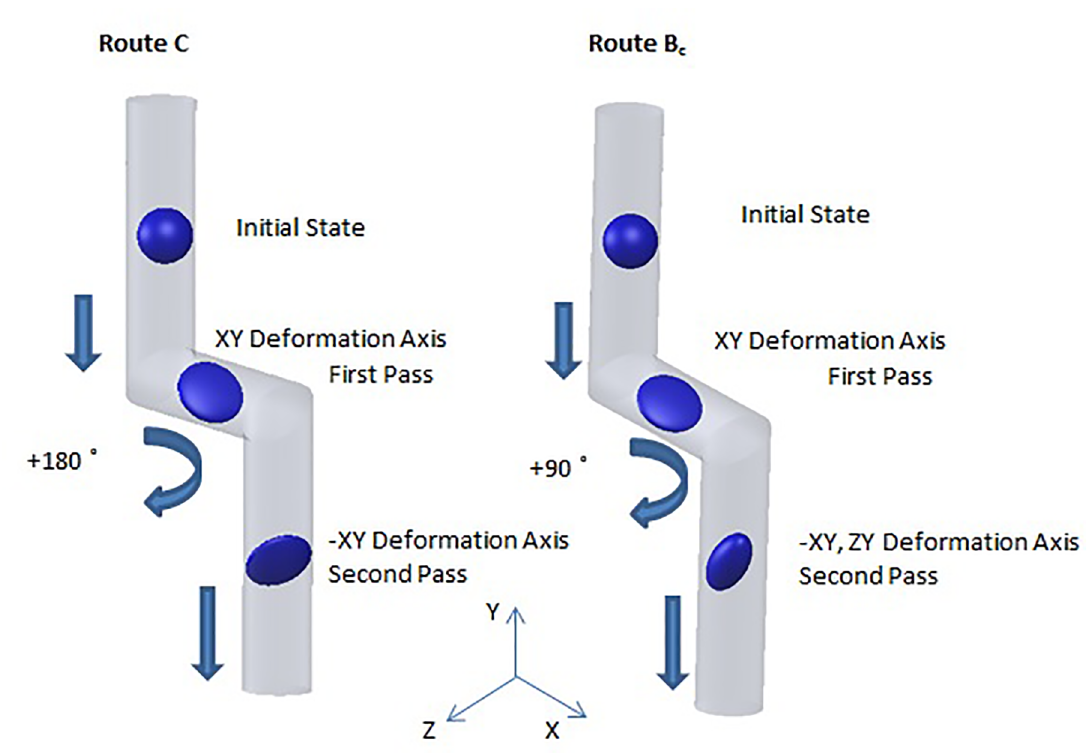
Figure 1. Deformation directions due to ECAP